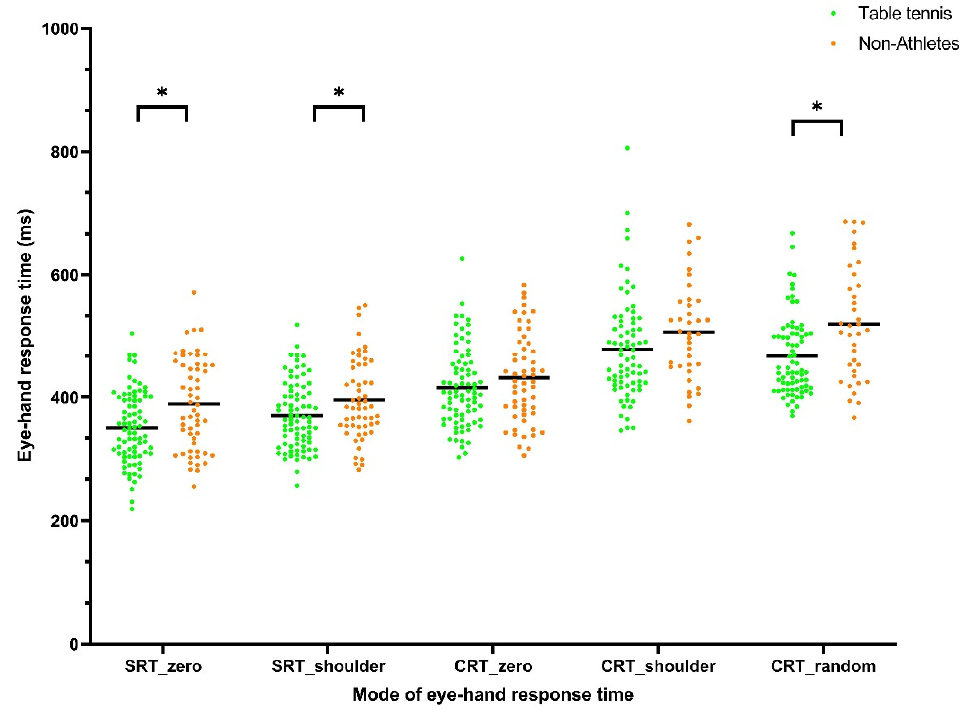
Figure 4. Eye–hand response time of table tennis athletes and non-athletes measured in five modes of eye–hand response time. (*: statistical significant between table tennis athletes and non-athletes). The correlation coefficients between stereopsis and eye–hand response time ranged from − 0.07 to 0.18. According to the sequential Bonferroni-type procedure, none of these correlation coefficients reached statistical significance (Table 2).